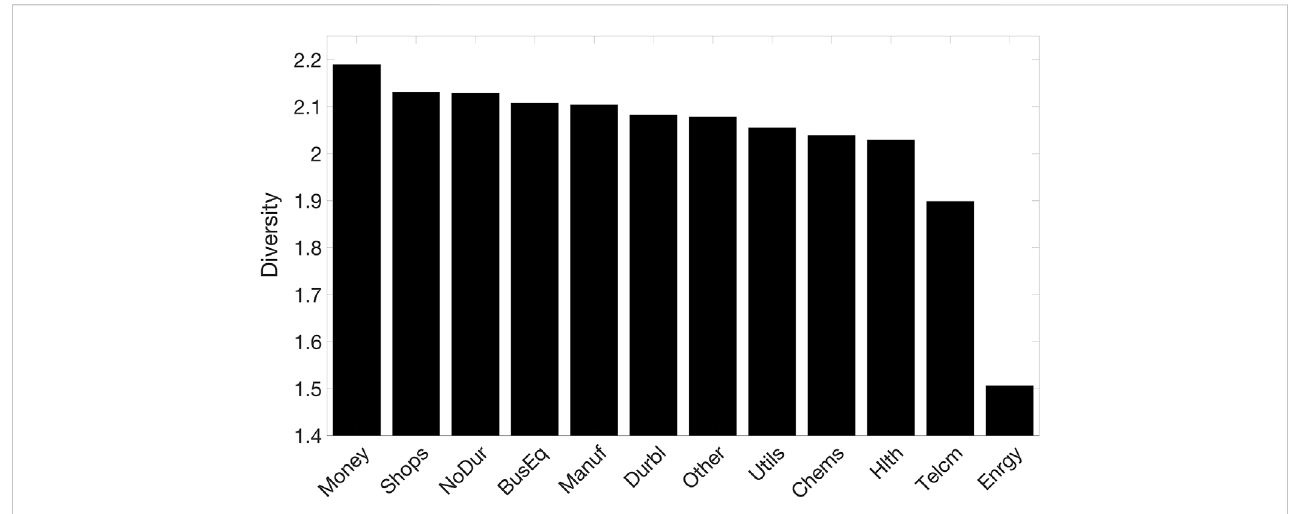
FIGURE 11 Industrialdiversityoftheinterlockingdirectoratesofoff-diagonalelementsduringthepre-crisisperiod.DiversityiscalculatedbytheShannonentropyof the interlocking ratio to each industry using the off-diagonal elements from the connected boards in